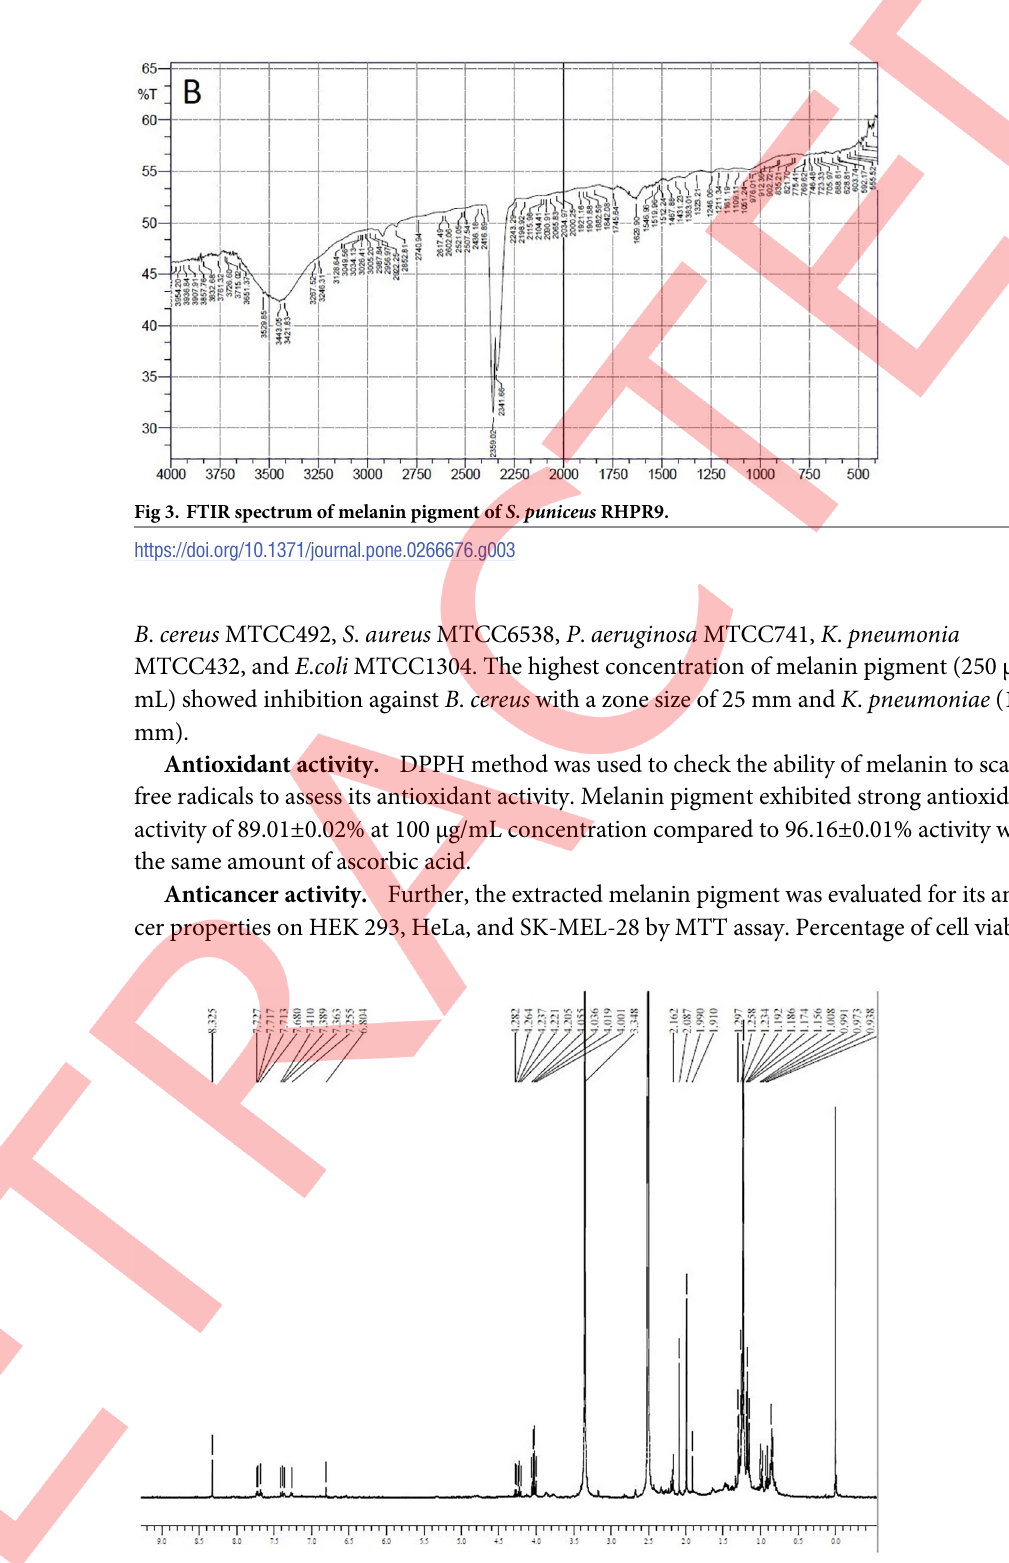
Fig 4. 1 HNMR Spectroscopy of the melanin pigment of S . puniceus